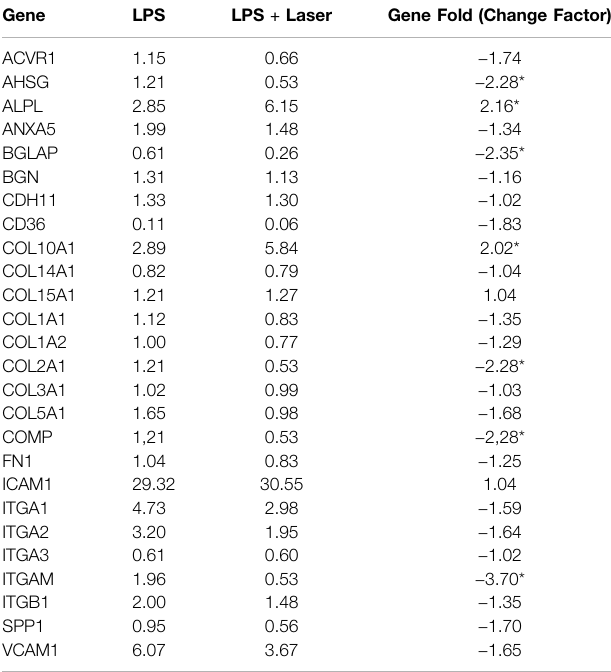
TABLE 1 | mRNA expression of cell adhesion and extracellular matrix proteins in DPSCs after and before laser irradiation.